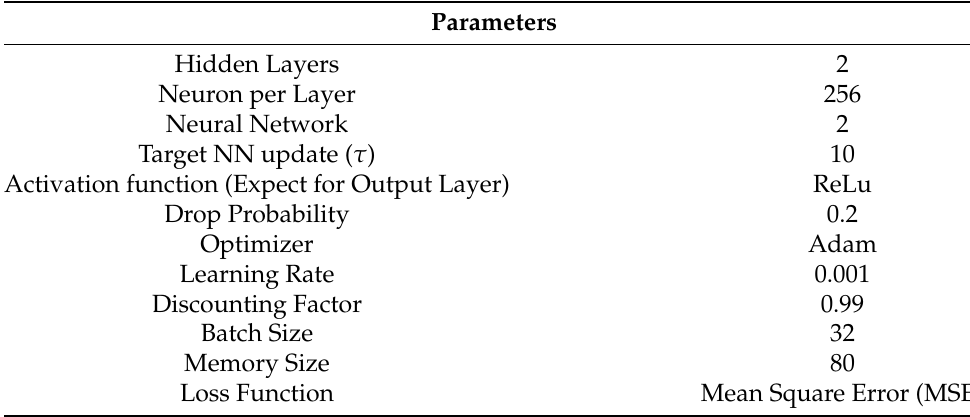
Table 2. DRL model